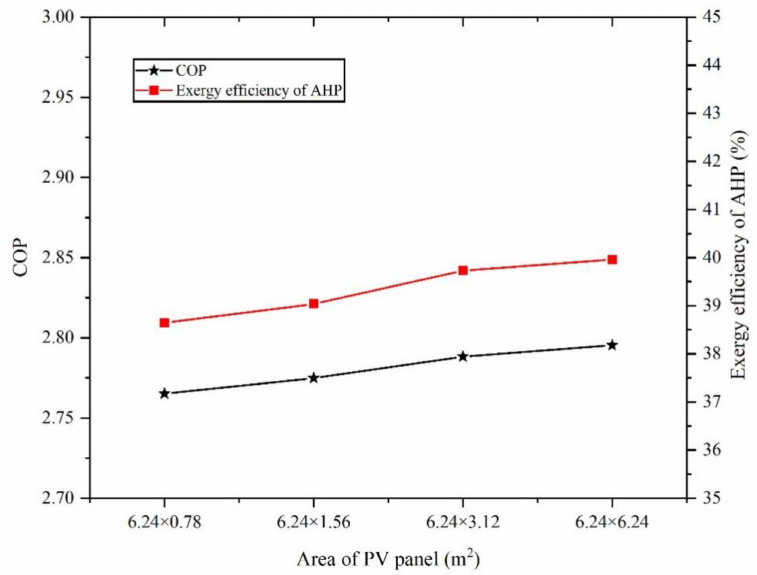
Figure 26. Variation of COP and exergy efficiency of the AHP under different PV cell